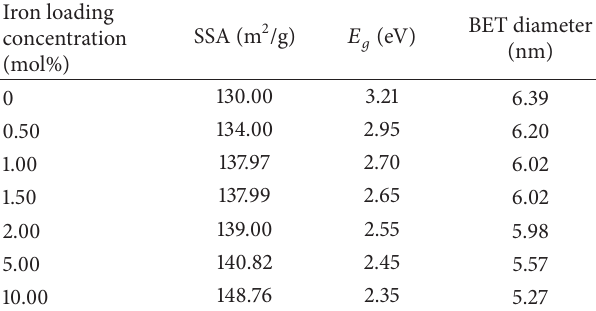
Table 2: Summary of analytical